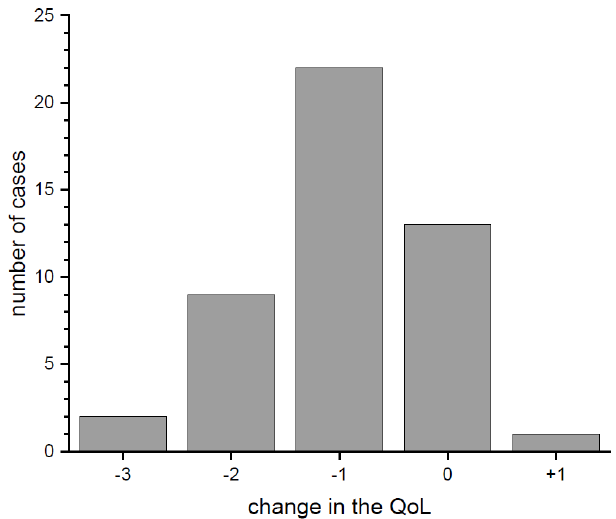
Figure 4. Changes in the level of the quality of life during the pandemic.